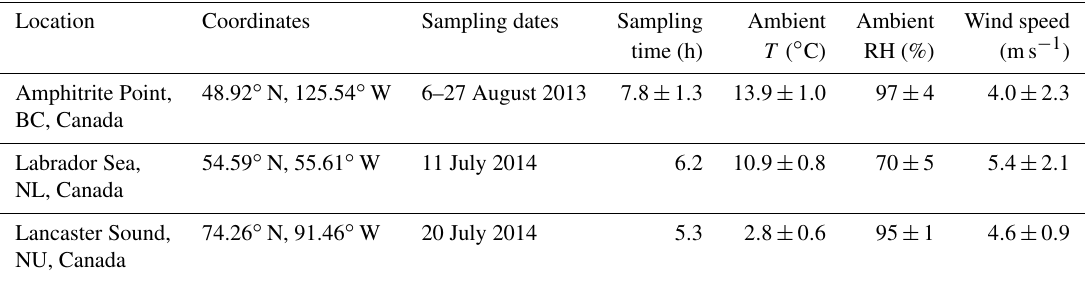
Table 1. The three sampling locations used in this study and conditions during sampling including ambient temperature ( T ) and relative humidity (RH). Included are the mean values and standard deviations. For Labrador Sea and Lancaster Sound, the coordinates are the locations at the midpoints of the sampling